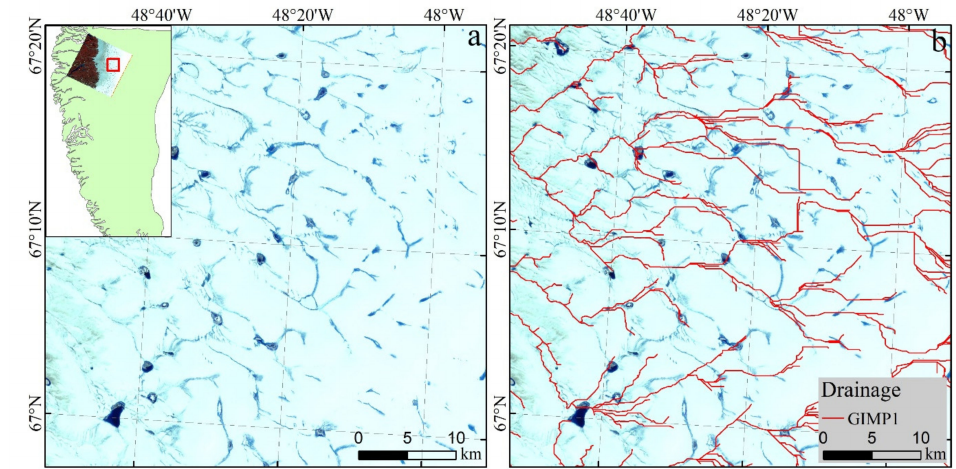
Figure 8. Verification of the GIMP1 river network extraction result. The basin name of the inset map is the Southwest basin. Panel ( a ) is the distribution of the actual river network, and panel ( b ) is the river network extraction result from the GIMP1 product. The background image is from Landsat-7 and was acquired on July 20,